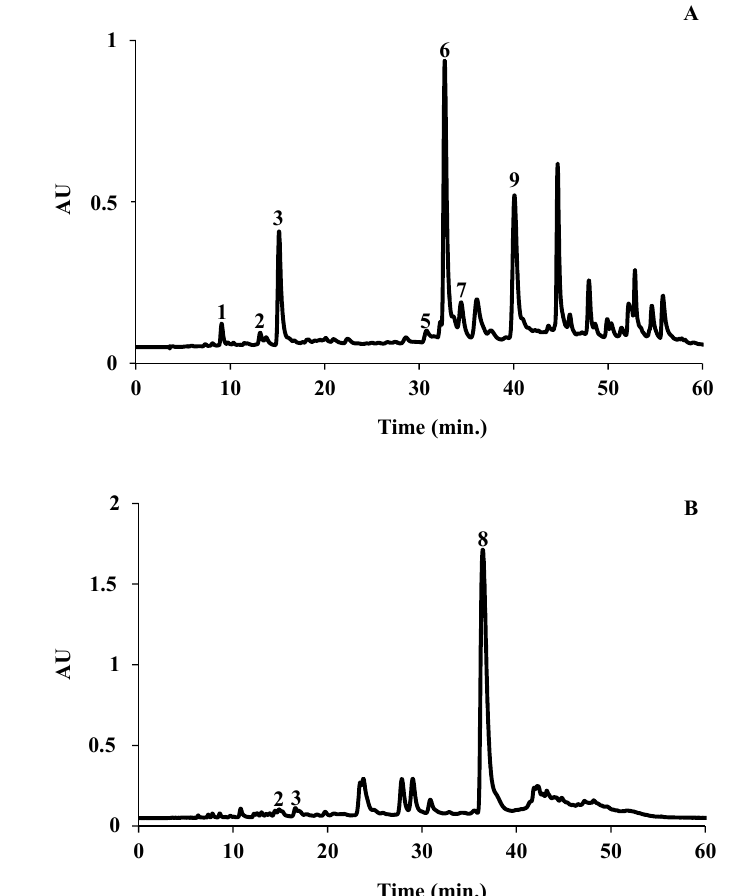
Figure 1. HPLC-DAD phenolic profile of the hydromethanolic extract of C. Canadensis ( A ) and of the aqueous extract of M. suaveolens ( B ). Detection at 320 nm. (1) 3- O -Caffeoylquinic acid, (2) 4- O - caffeoylquinic acid, (3) 5- O -caffeoylquinic acid, (5) 3,4-di- O -caffeoylquinic acid, (6) 3,5-di- O -caffeoylquinic acid, (7) 3,4-di- O -caffeoylquinic acid, (8) rosmarinic acid and (9) 4,5-di- O -caffeoylquinic Table 2. Phenolic composition of the extracts from the M. suaveolens (MS), C. canadensis (CC), S. verbenaca (SV) and T. polium (TP).